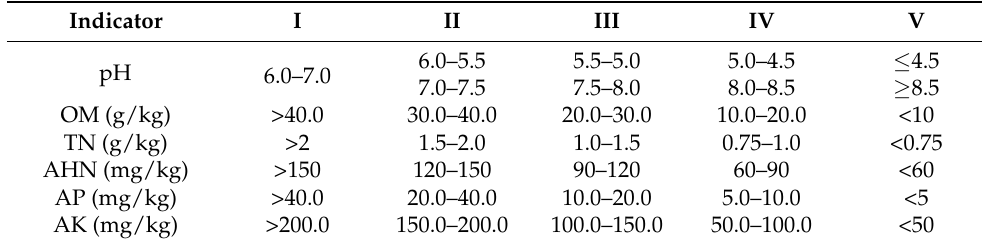
Table 1. Classification standards used for soil fertility